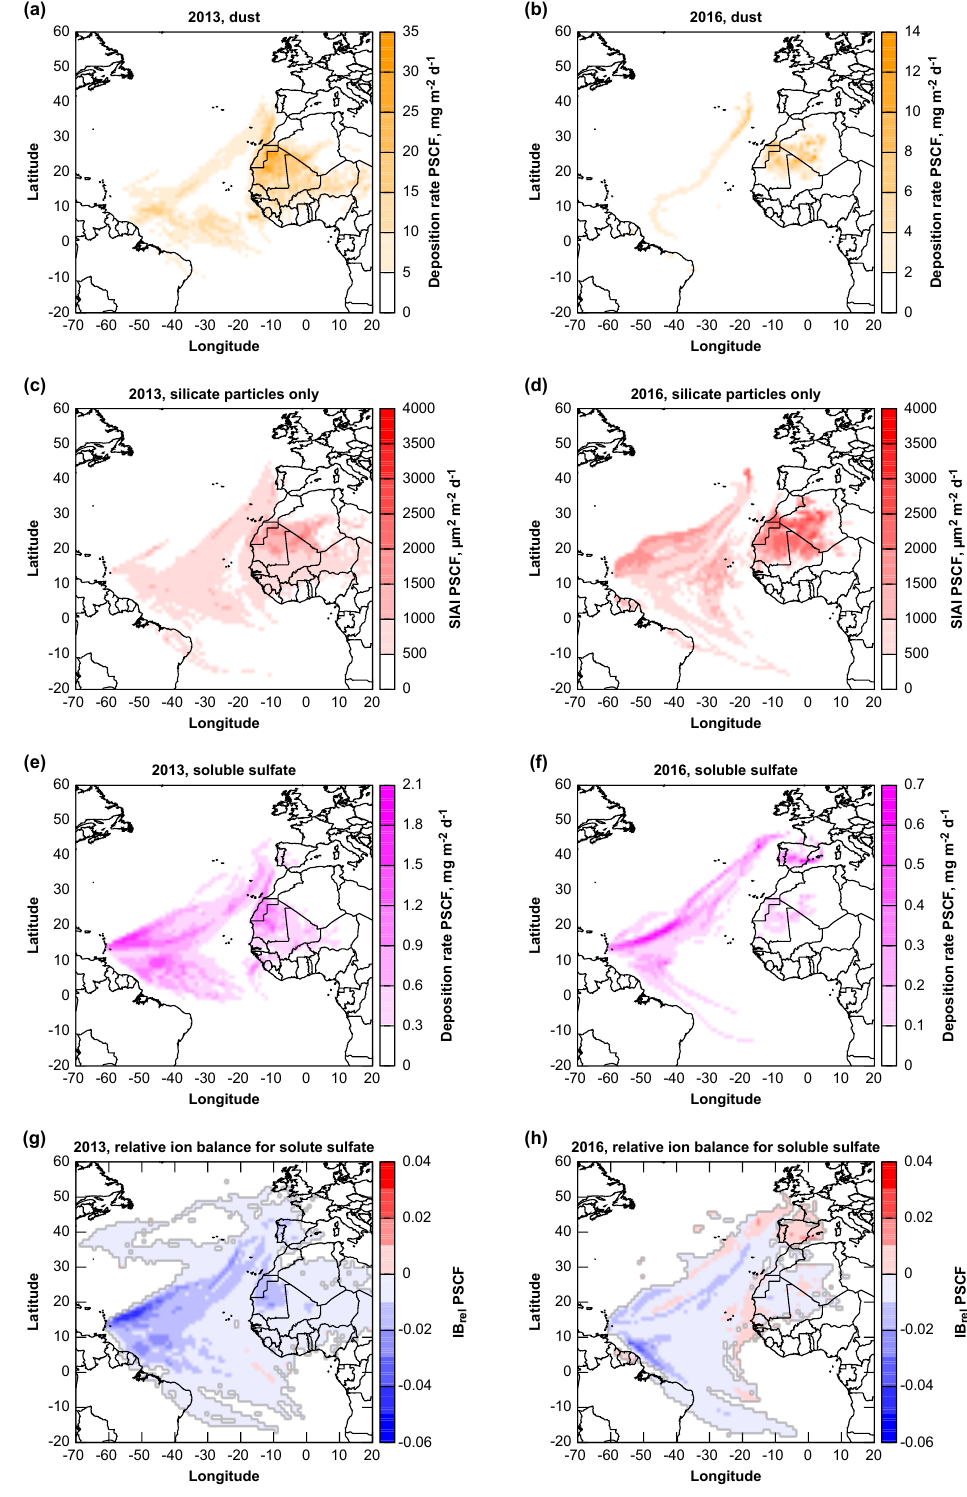
Figure 14. Potential source contribution functions (PSCF) of deposited material: dust (a, b) , geometric silicate iron availability index SIAI (c, d) , total soluble sulfate (e, f) and relative ion balance for sulfate particles (g, h) for 2013 and 2016 at Ragged Point. Note that for panels (a–d) , potential provenance is calculated for Saharan Air Layer transport only (i.e., trajectory arrival altitudes >